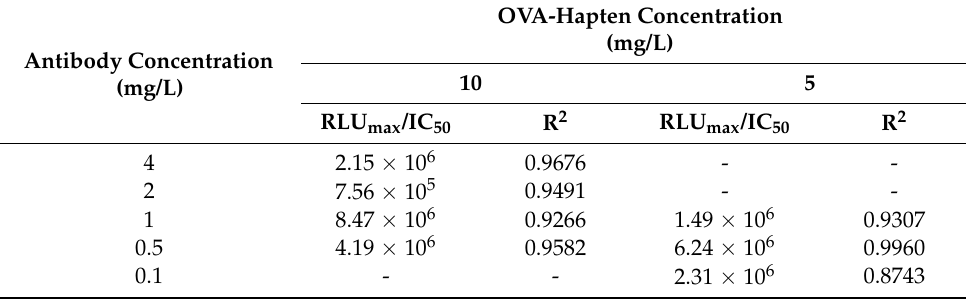
Table 1. The optimal concentrations of antigen and antibody for Cl-ELISA.